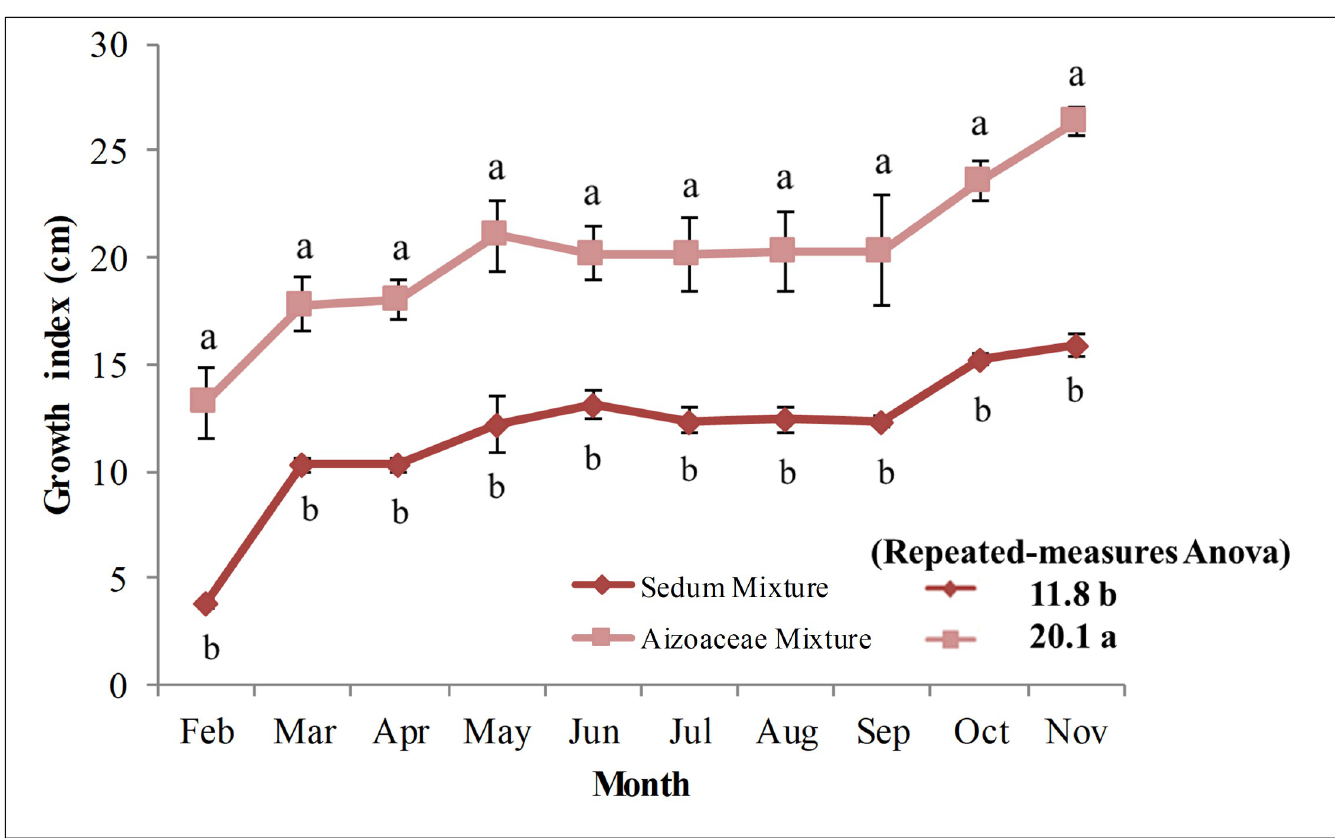
Fig 3. Plant Growth Index for two succulent mixtures (Feb-Nov 2011). Values are means ± SE. For each data, histograms with different letters are significantly different at p � 0.05.